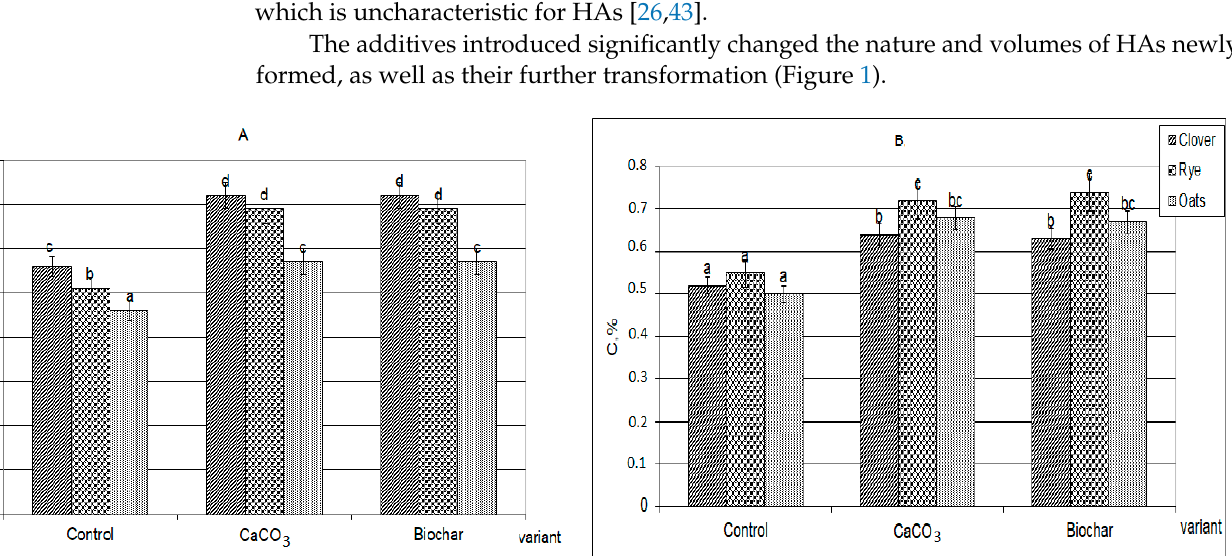
Figure 1. The amount of newly formed humic acids formed during the decomposition of plant residues extracted with 0.1 M Na 4 P 2 O 7 solution, C, %: ( A )–30 days, ( B )–90 days (the same small letters mean no significant differences between the values at the level of significance p < 0.05, n = 4; one-way ANOVA, Student-Newman-Keuls test).